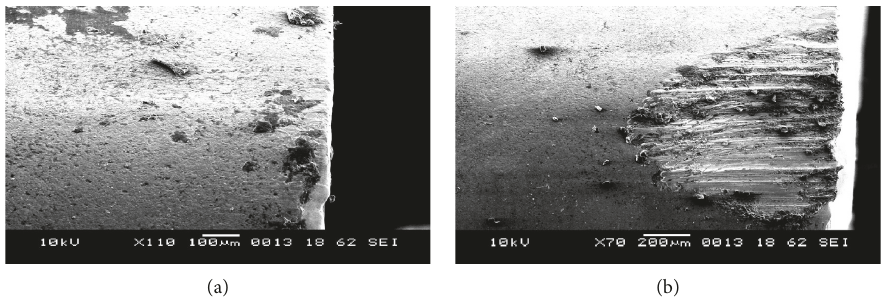
Figure 7: Scanning electron micrographs of the wear zone of carbide inserts (a) 2 and (b)